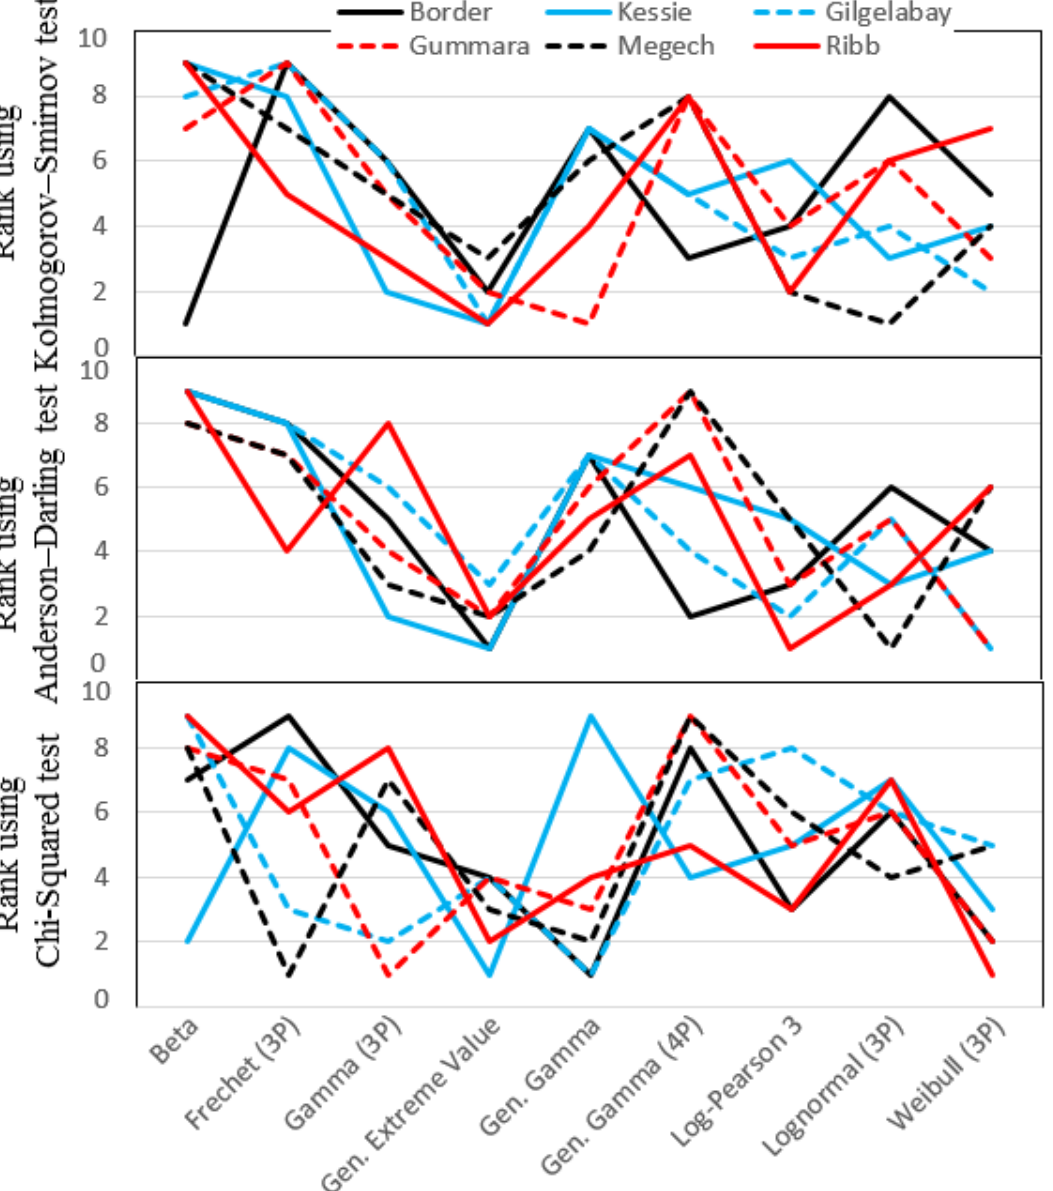
Figure 4. Plot shows the rank of each probability distribution function computed with three goodness of fit test statistics at all selected gauging stations in the Blue Nile River